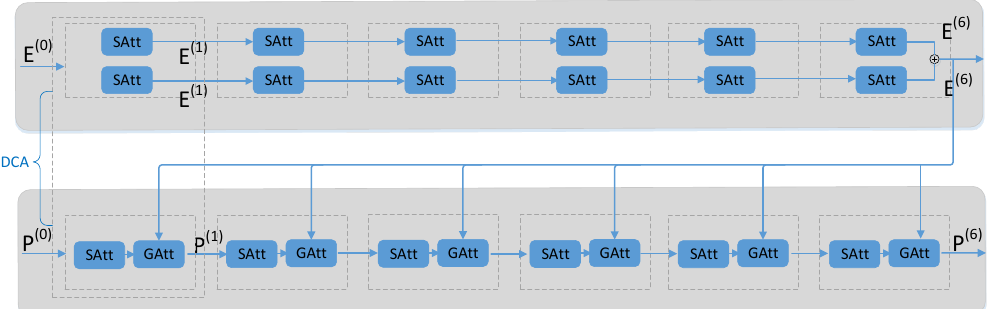
Figure 4. Dense multimodal co-attention model. ⊕ denotes adding up the question